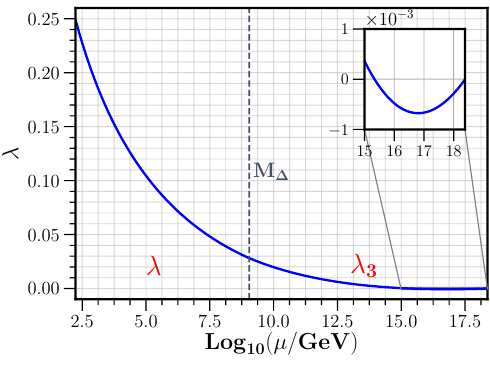
Figure 3 . Running of the Higgs quartic coupling with the logarithm of the scale in the type II seesaw using the 2-loop RGEs. We used the values given in eq. (3.1) for M t = 170 . 97 GeV as well as the extrapolation to M pl described in the beginning of section 3. We required that λ i ( M pl ) = γ ( M pl ) = 0 with i = 1 , 2 , 3 , 4 , 5 and used M ∆ = 10 9 GeV and Y ∆ ( M pl ) = 1 , which yields a stable triplet potential. The negative value of λ between µ ∼ 10 15 − 10 18 GeV makes the stability issue a bit worse than in the SM. Right-handed neutrinos help stabilise the